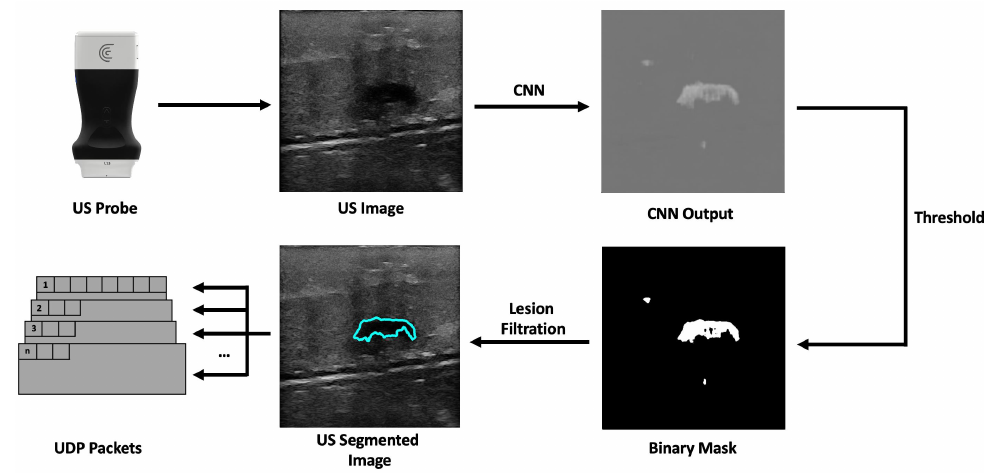
Figure 2. Companion application workflow